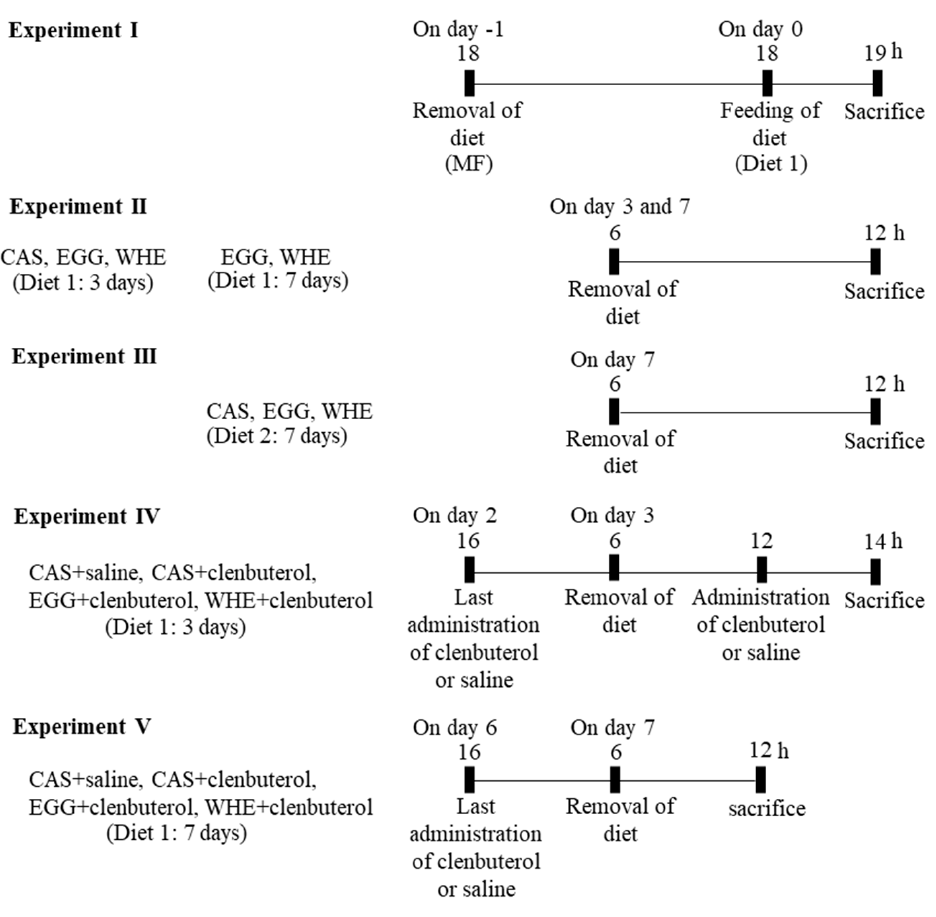
Figure 1. Experimental design.